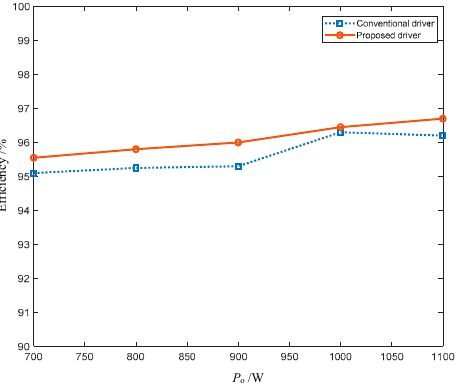
Figure 12. Efficiency of synchronous buck with the conventional driver and the proposed driver.